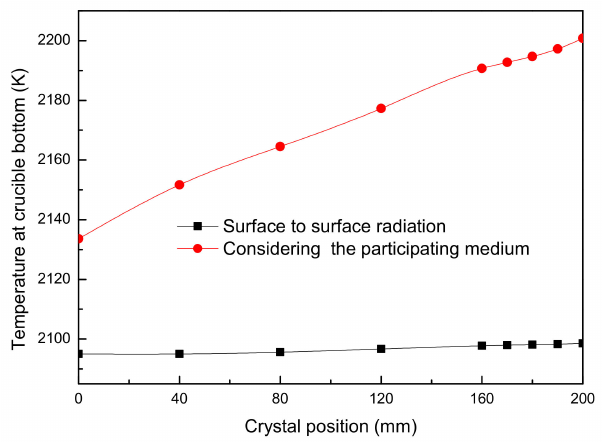
Figure 6. Temperature at the crucible bottom during the dynamic growth process to help us consider the participating medium and the surface to surface